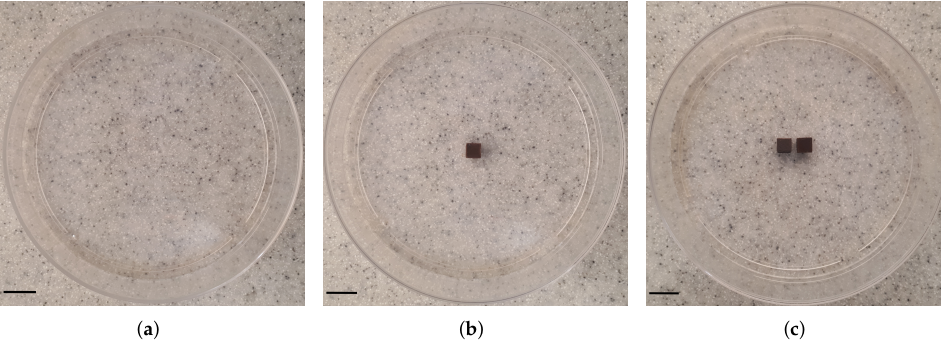
Figure 3. Photographs of the configuration of MNP-10 implant(s) in agarose gel. Three samples were studied: agarose gel and ( a ) no (studied as control), ( b ) one and ( c ) two (interval between them is 0.5 cm) implant(s). The samples were placed into 90 mm cell culture dishes. Scale bar: 1.0